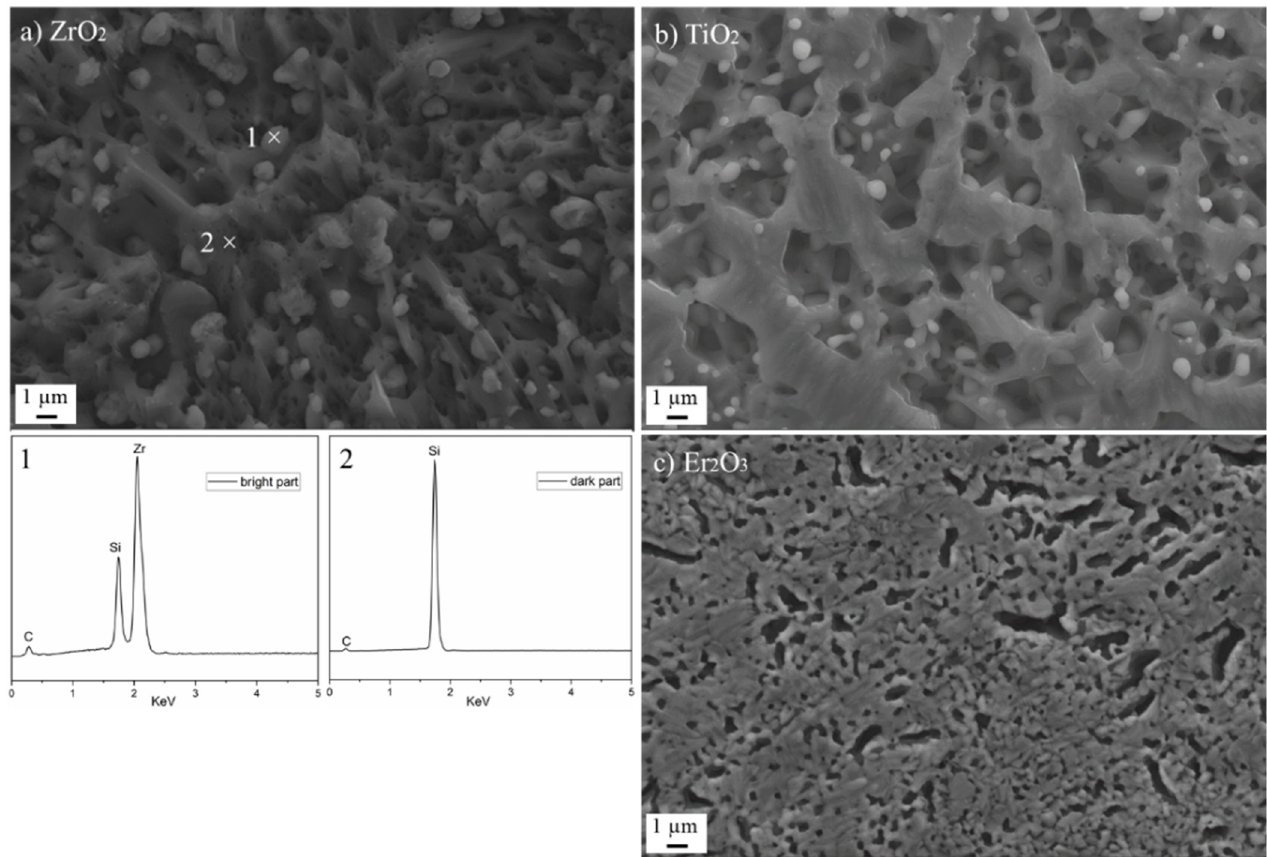
Figure 15. SEM images and EDS (spot scan) of dipped oxides coating after 1600 °C, 2 h